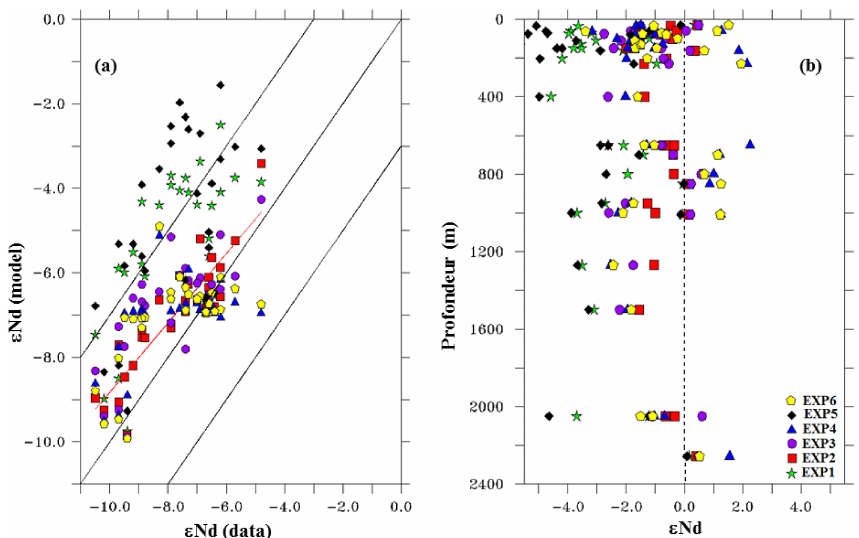
Figure 4. Model–data comparison for the six simulations performed with different relaxing time at the steady state (see Table 3) and the in situ data from Tachikawa et al. (2004), Vance et al. (2004) and Henry et al. (1994): (a) model–data correlation, red line is the linear regression from EXP2. Diagonal dashed lines are lines ε Nd (modelled) = ε Nd (data), ε Nd (modelled) = ε Nd (data) + 3 ε Nd and ε Nd (modelled) = ε Nd (data) − 3. (b) Model–data comparison as a function of depth, dashed solid line represents the data from Tachikawa et al. (2004), Vance et al. (2004) and Henry et al.